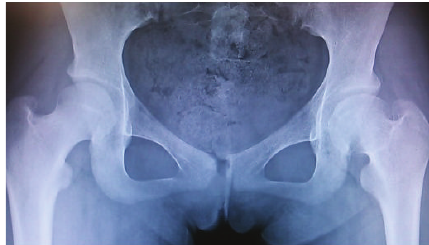
Figure 6: Bone scintigraphy findings. A cold-in-hot pattern is shown at the left femoral capital epiphysis (arrow).